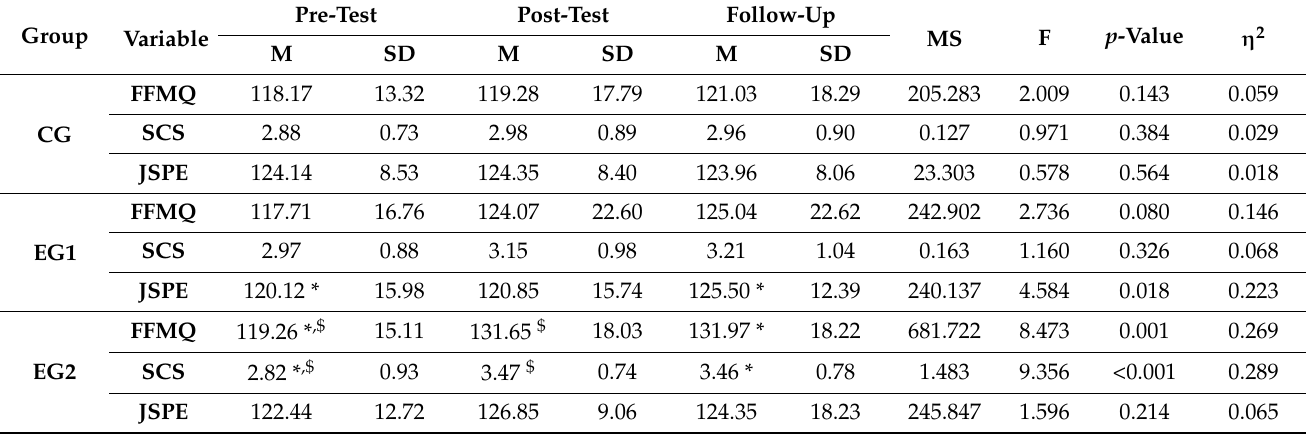
Table 3. Intra-group comparisons of FFQM, SCS and JSPE, using ANOVA for repeated measures. Group